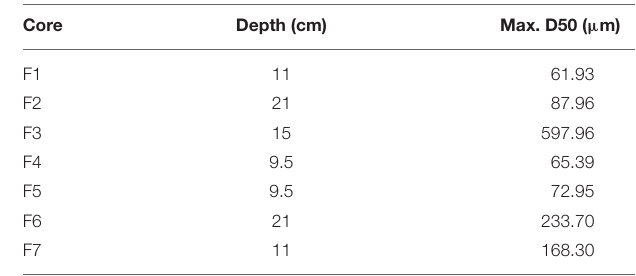
TABLE 1 | Comparison between 210 Pb and 137 Cs dates for the cores displayed in Figure 7 .